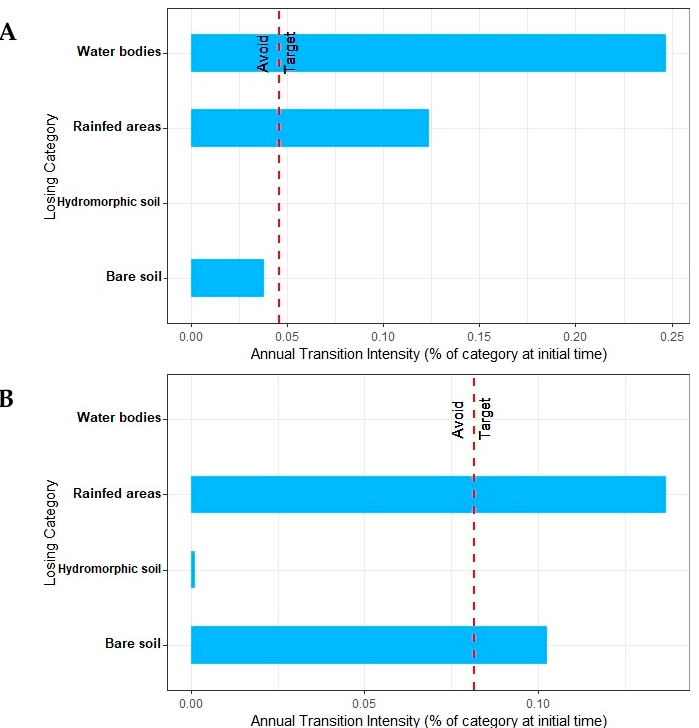
Figure 7. Annual transition intensity for gain of irrigated areas between 1987–2000 ( A ) and 2000–2015 ( B ) in the Mogtedo region.